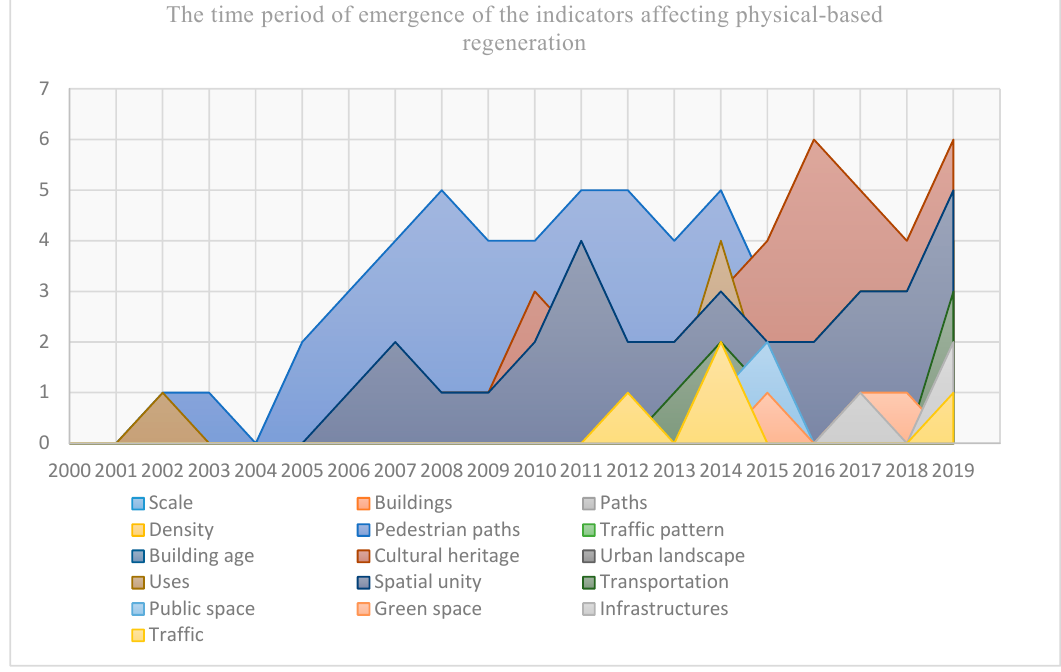
Figure 6. Time period of emergence of the indicators affecting physical-led regeneration.